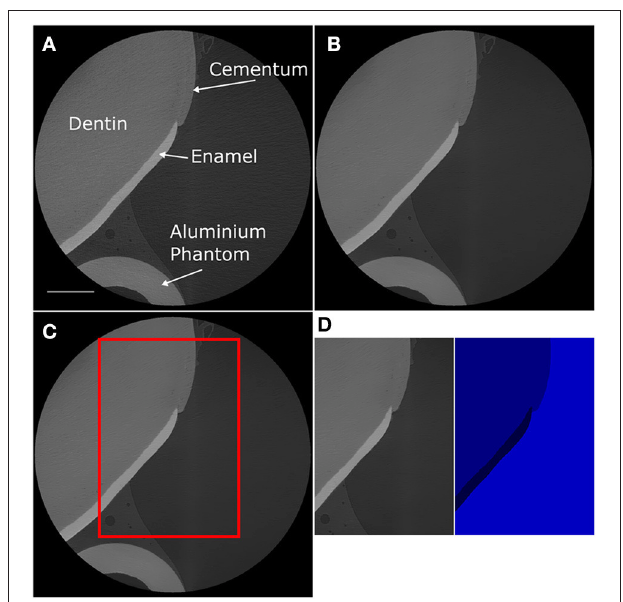
FIGURE 1 | Optical image of the ex situ brushing set up. Static weights are applied to the central portion of the electric toothbrush. The tooth sample is mounted in the XCT sample holder and stabilized by a steel v-block. A schematic of the brushing location is shown in the bottom left hand corner of the image.